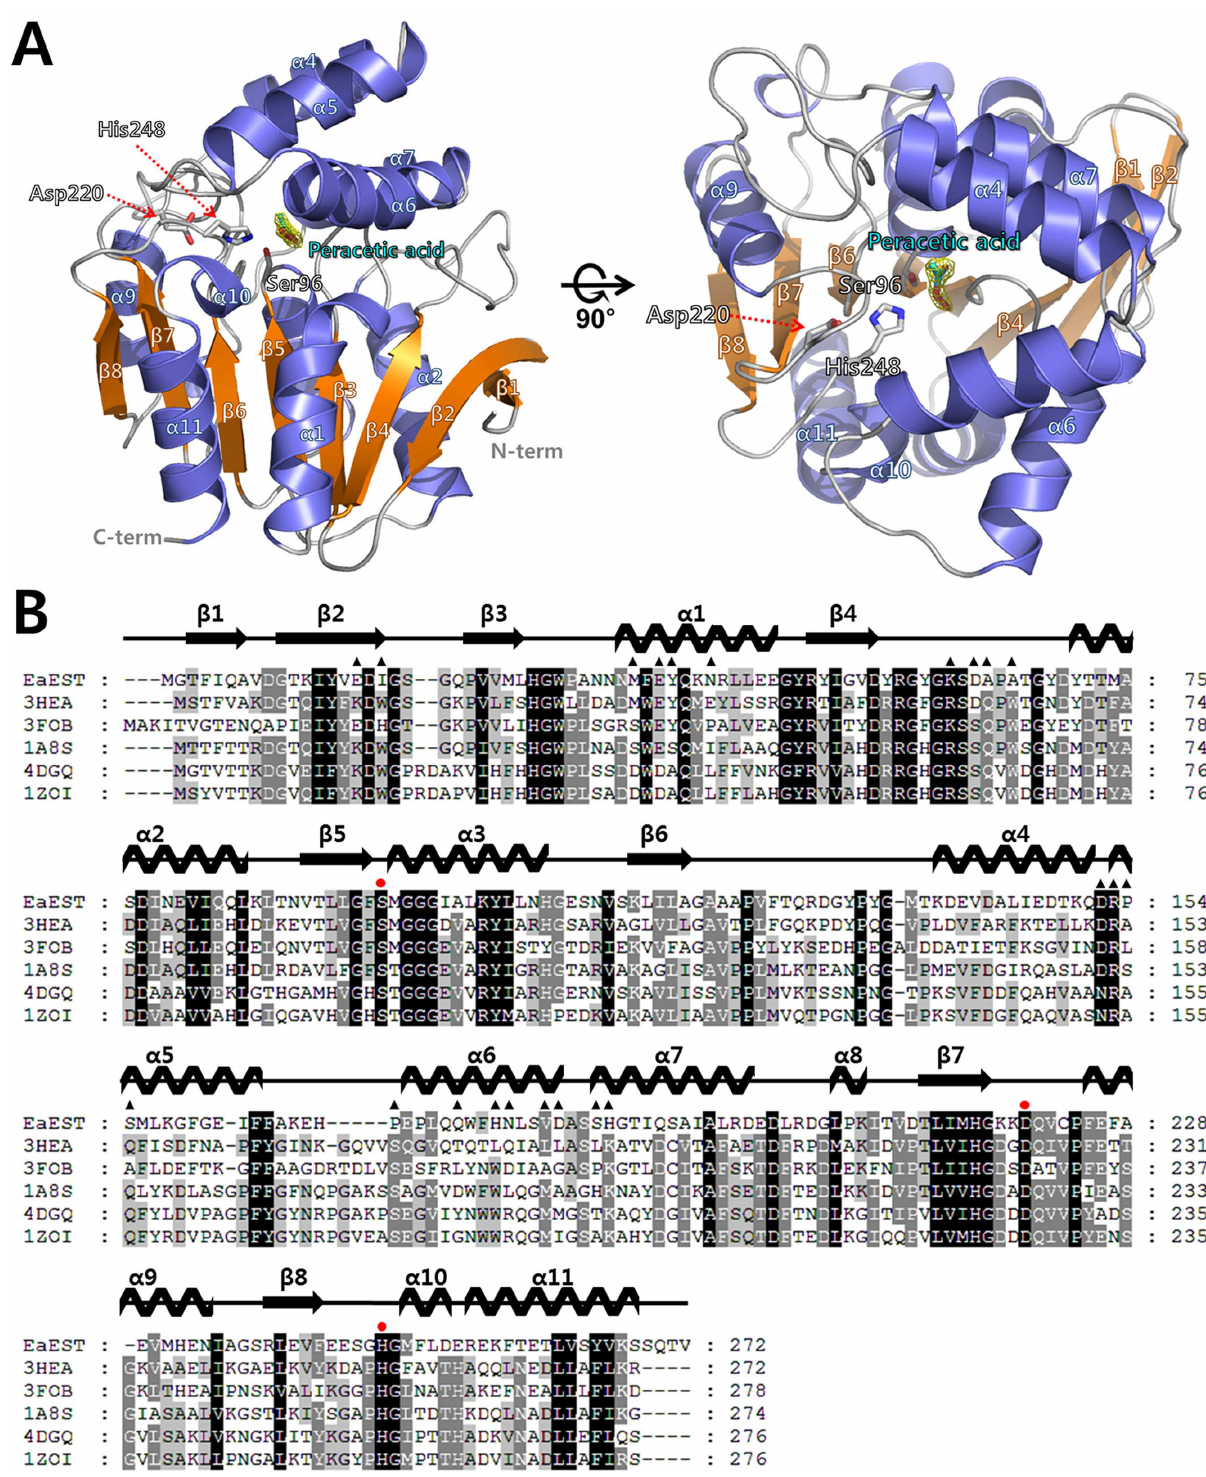
Fig 1. Crystal structure of peracetate-bound Ea EST. ( A ) Overall structure of monomeric Ea EST is shown in front view (left panel)and top view (right panel)rotated at 90˚. The structure of Ea EST was drawn as a ribbondiagram with α -helicescolored slate blueand β -strands colored orange. Bound peracetate molecule(cyan) is shown as a stick model with a 2Fo-Fc electron-density map (green) at 1.0 σ . The catalytic triad residues(Ser96, Asp220, and His248)are shown as stick models. N - and C -terminiare labeledin gray letters and